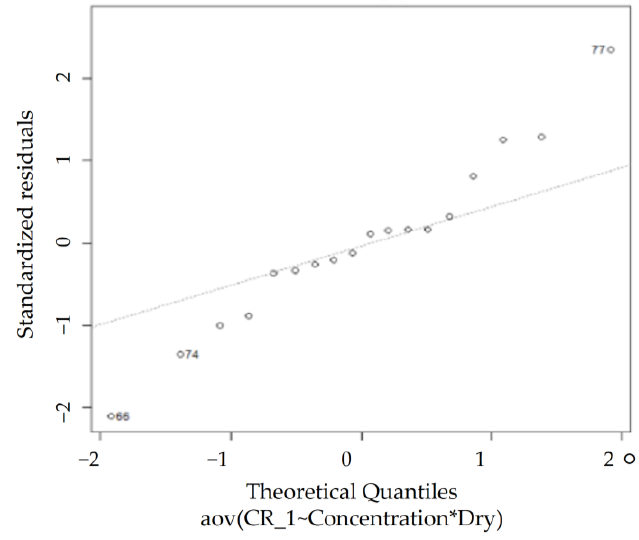
Figure 21. PT normal QQ